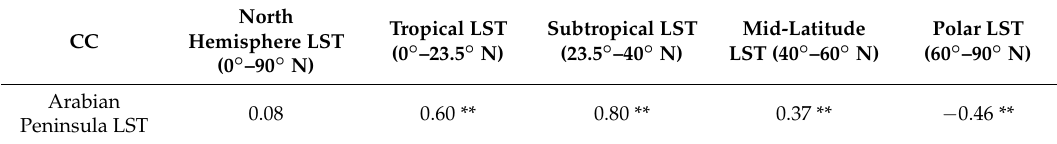
Table 1. The correlation coefficient between the Arabian Peninsula LST and the North Hemisphere LST (0 ◦ –90 ◦ N), tropical LST (0 ◦ –23.5 ◦ N), subtropical LST (23.5 ◦ –40 ◦ N), mid-latitude LST (40 ◦ –60 ◦ N), and polar regions LST (60 ◦ –90 ◦